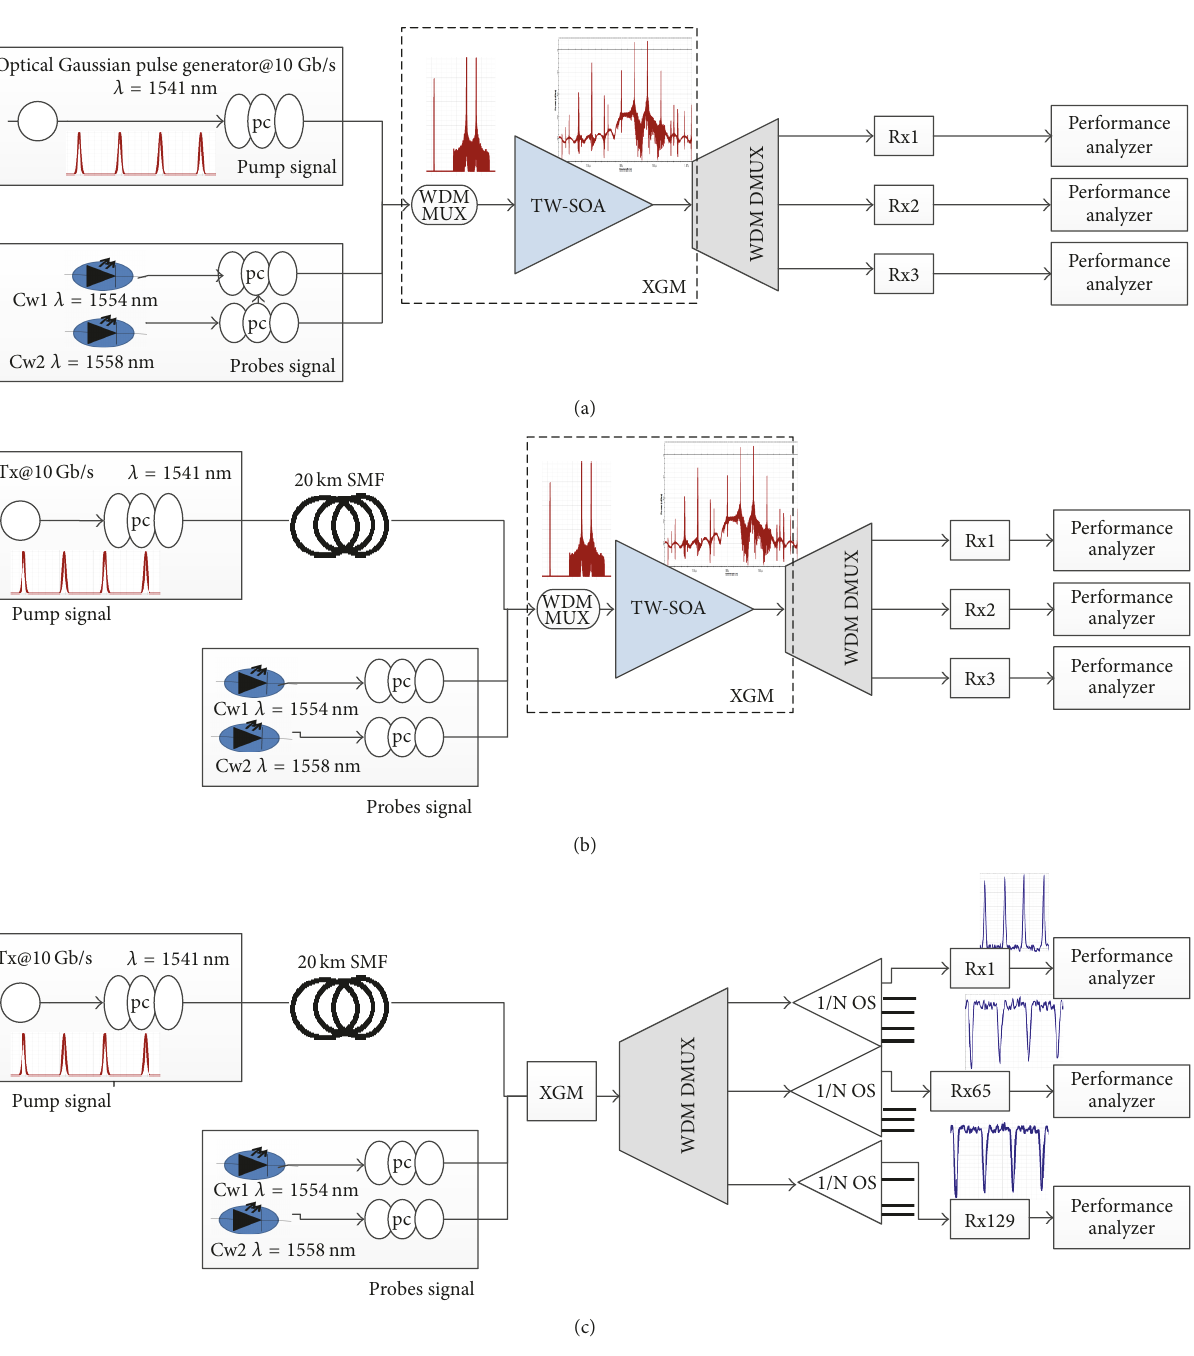
Figure 1: System configuration: (a) point to point no fiber at (b) 20 km SMF and (c) 20 Km SMF + optical